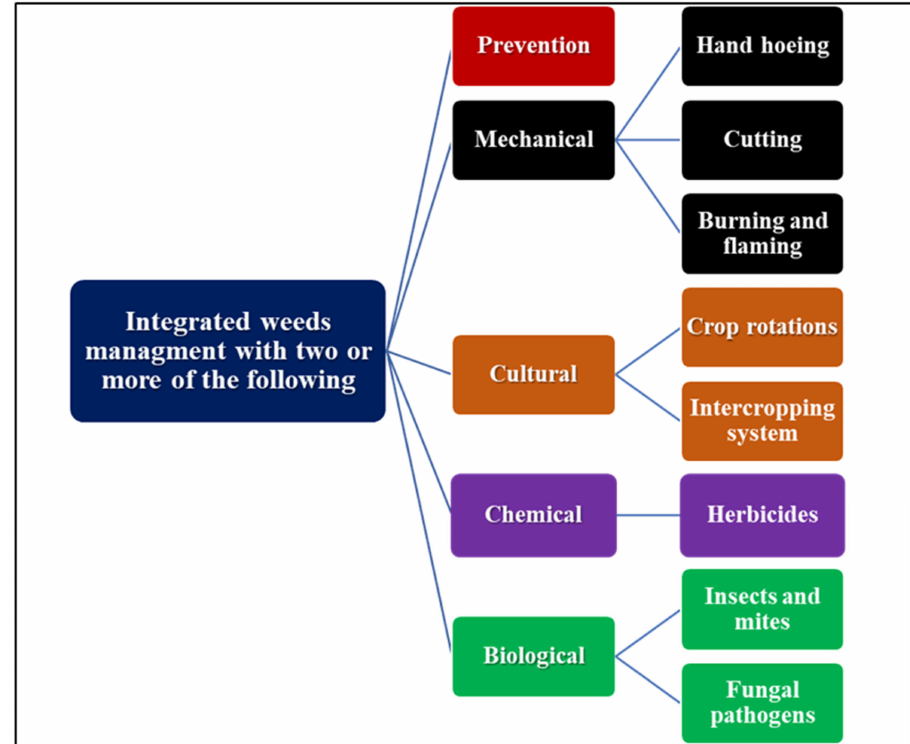
Figure 3. Integrated weed